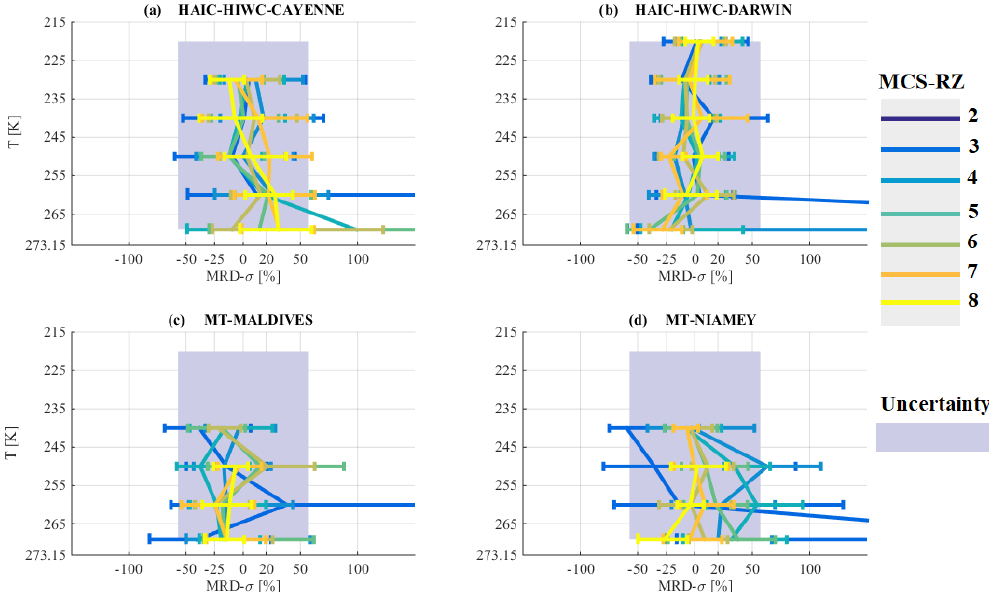
Figure 8. The same as Fig. 6 but for visible extinction MRD- σ